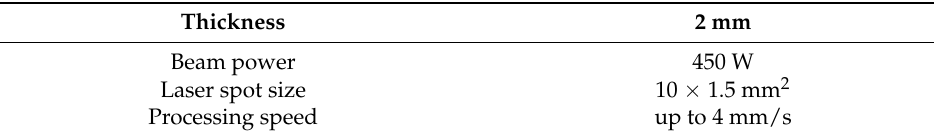
Table 3. Conditions for laser annealing of a low-alloyed titanium alloy.